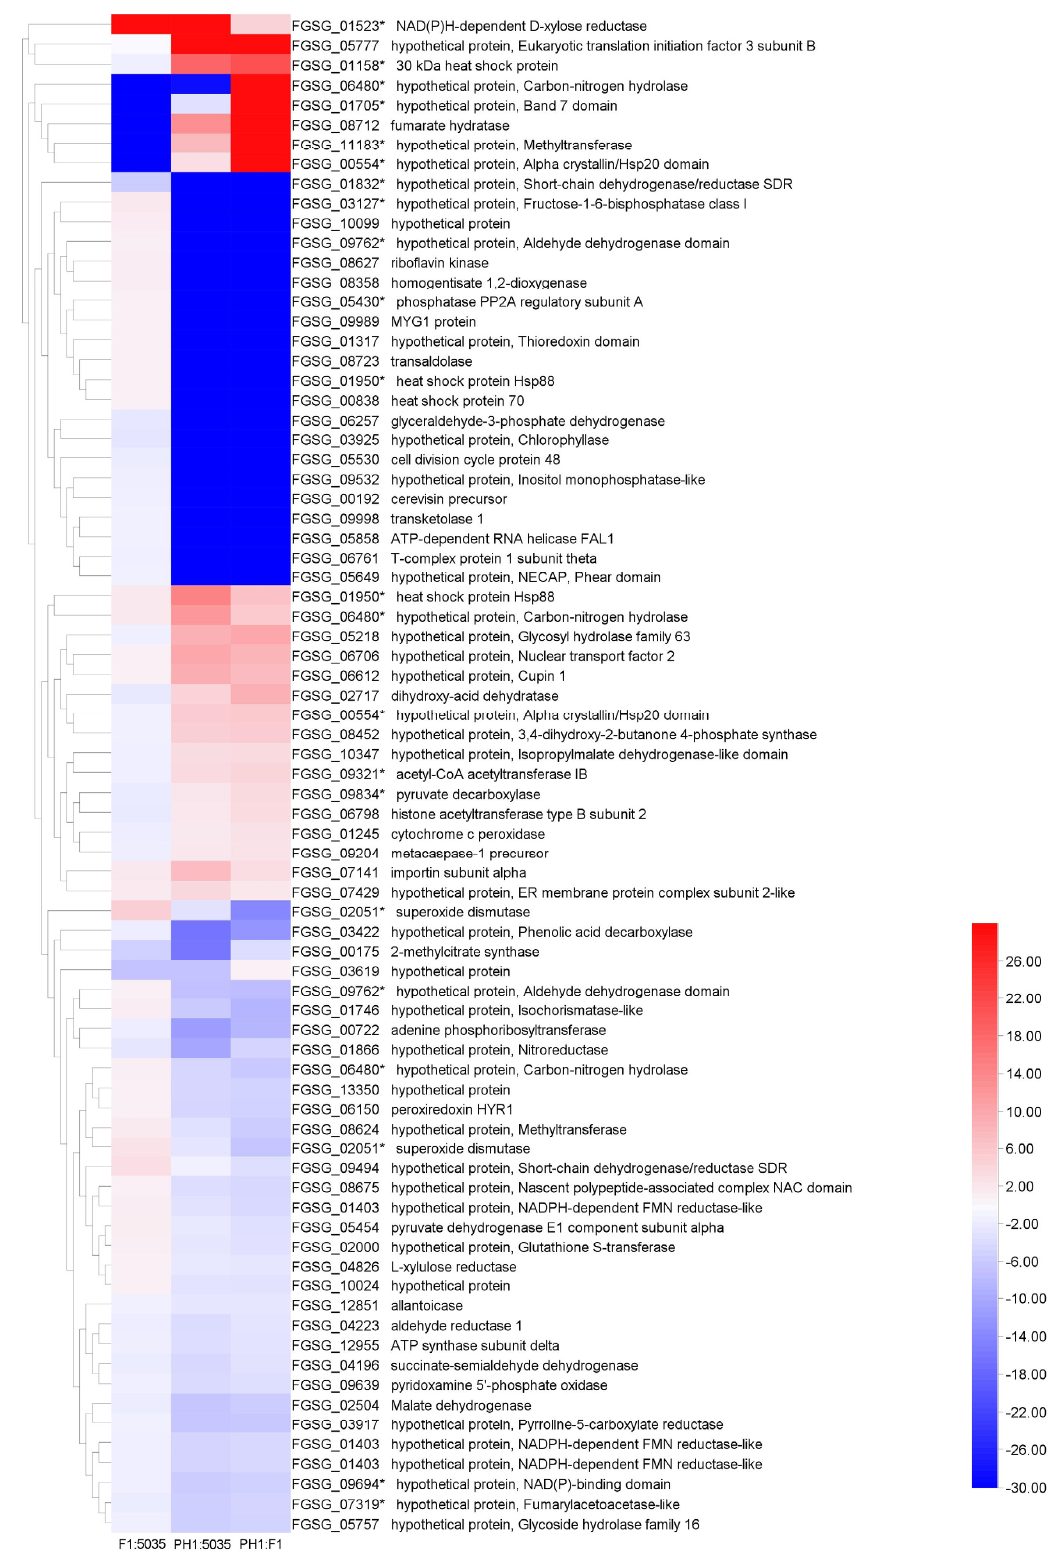
Figure 5. The heat map of 77 protein spots. Sixteen FGSG genes (identified in 22 protein spots) determined as DEGs in microarray analyses are indicated with asterisks. Blue represents lower expression; red represents higher expression.